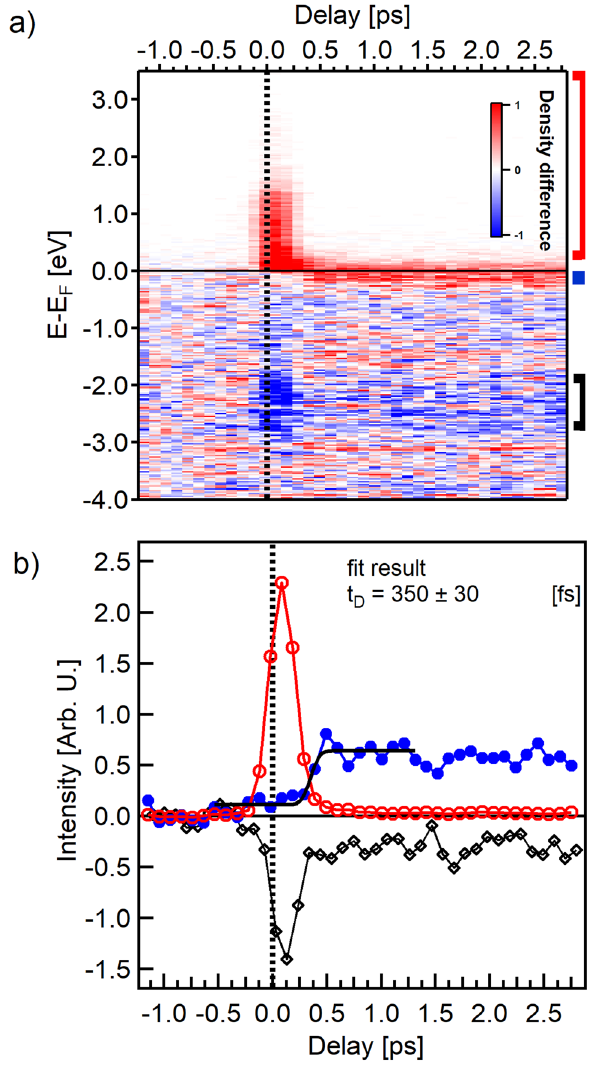
Fig. 4 Subpicosecond generation of the electronic FM order in FeRh. a Energy- and delay-dependent differential matrix of the measured photoelectron spectra. We subtracted the average of unpumped spectra (between − 1 ps and − 0.5 ps) from each measured spectrum. The effect of laser excitation is evident around time zero, indicating depletion of the occupied states and the corresponding population of the empty states. In addition, an increase in the electronic density close to the Fermi level is observed at positive time delays. The red, blue, and black bars on the right hand side mark the representative integration regions for tracking the electronic dynamics in the unoccupied states, the formation of the Fe minority peak, and the modi fi cation of the deeper bands, respectively. b Temporal evolution of the electronic density in the three characteristic energy regions marked in ( a ). The population of states above the Fermi level shows a fast rise and a consecutive decay around t 0 (empty red circles). The deeper bands (empty black diamonds) show a corresponding depletion and recovery which re fl ects the dynamics of the unoccupied states. However, their occupation level stabilizes 300 fs after t 0 and remains constant thereafter. The electronic density slightly below E F ( fi lled blue circles) shows a moderate increase during the laser excitation up to 300 fs delay, followed by a pronounced increase due to the shift of Fe minority band below E F at a delay t D of 350 fs. This value was extracted by fi tting the error function to the experimental results (black solid line). Subsequently, the minority Fe band peak intensity remains constant throughout the investigated delay